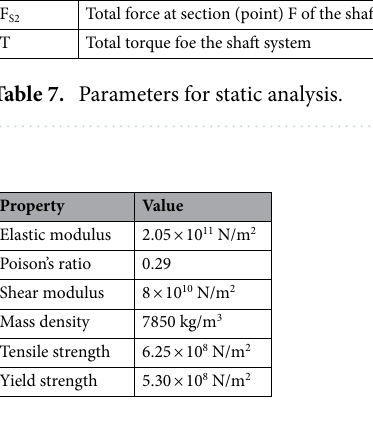
Table 8. Properties of the shaft material.